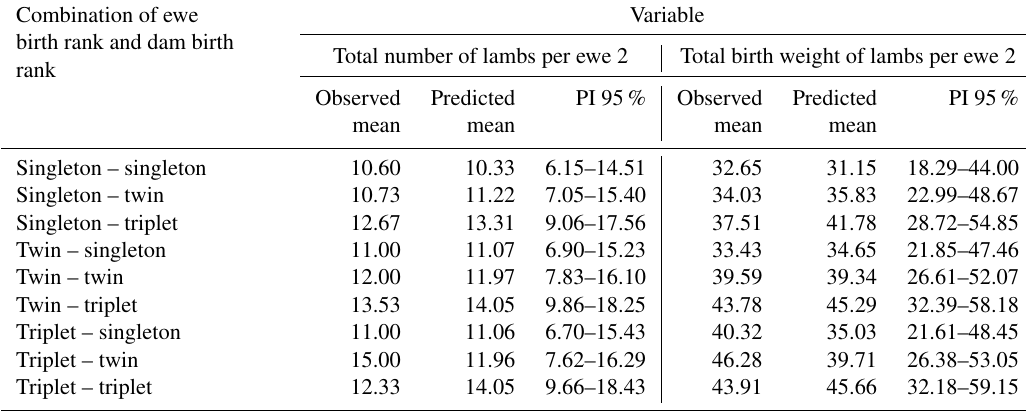
Table 5. Means and prediction intervals of reproductive performance up to the fourth year of ewe’s life for the combination of ewe birth rank and dam birth